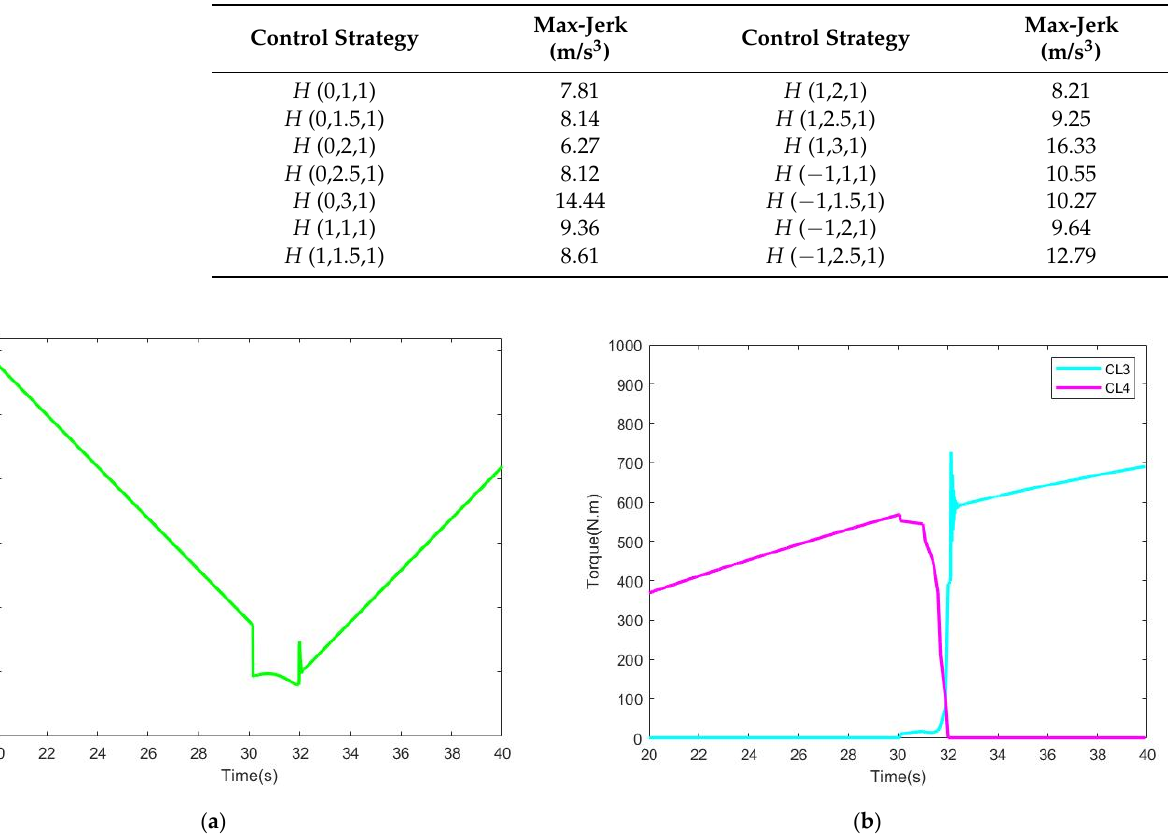
Figure 17. Amplitude change of the jerk in different control strategies ( H = (x,y,1)). Table 2. Jerk corresponding to different control strategies.